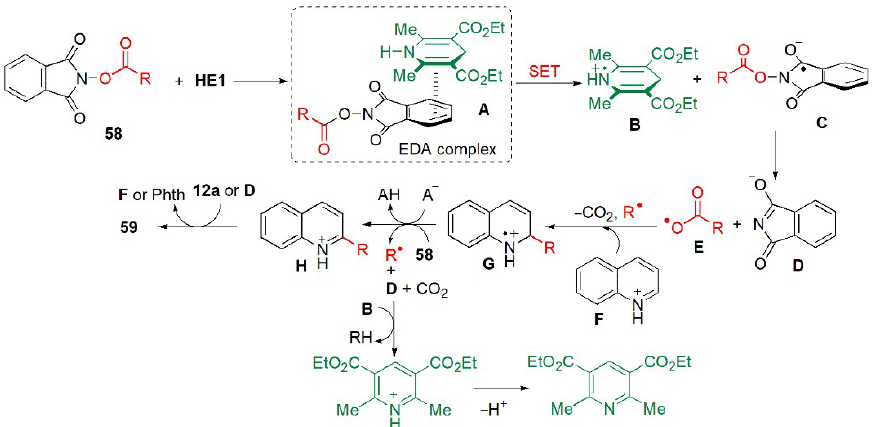
Figure 20. Enantioselective Minisci-type alkylation of N -heteroarenes by N -(acyloxy)phthalimide esters [92].